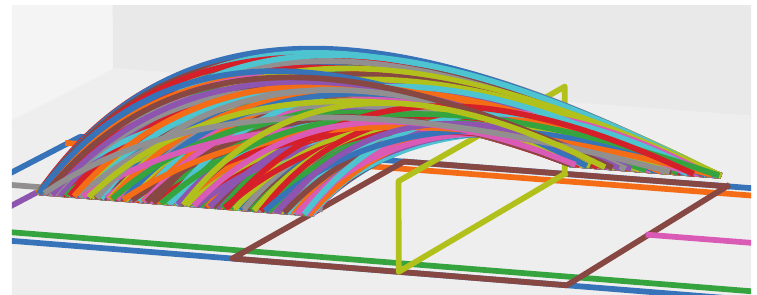
Figure 3. Five thousand good serves launched (trajectories from right to left) with randomized launch positions, directions and speeds from the serve height of 1.18 m.